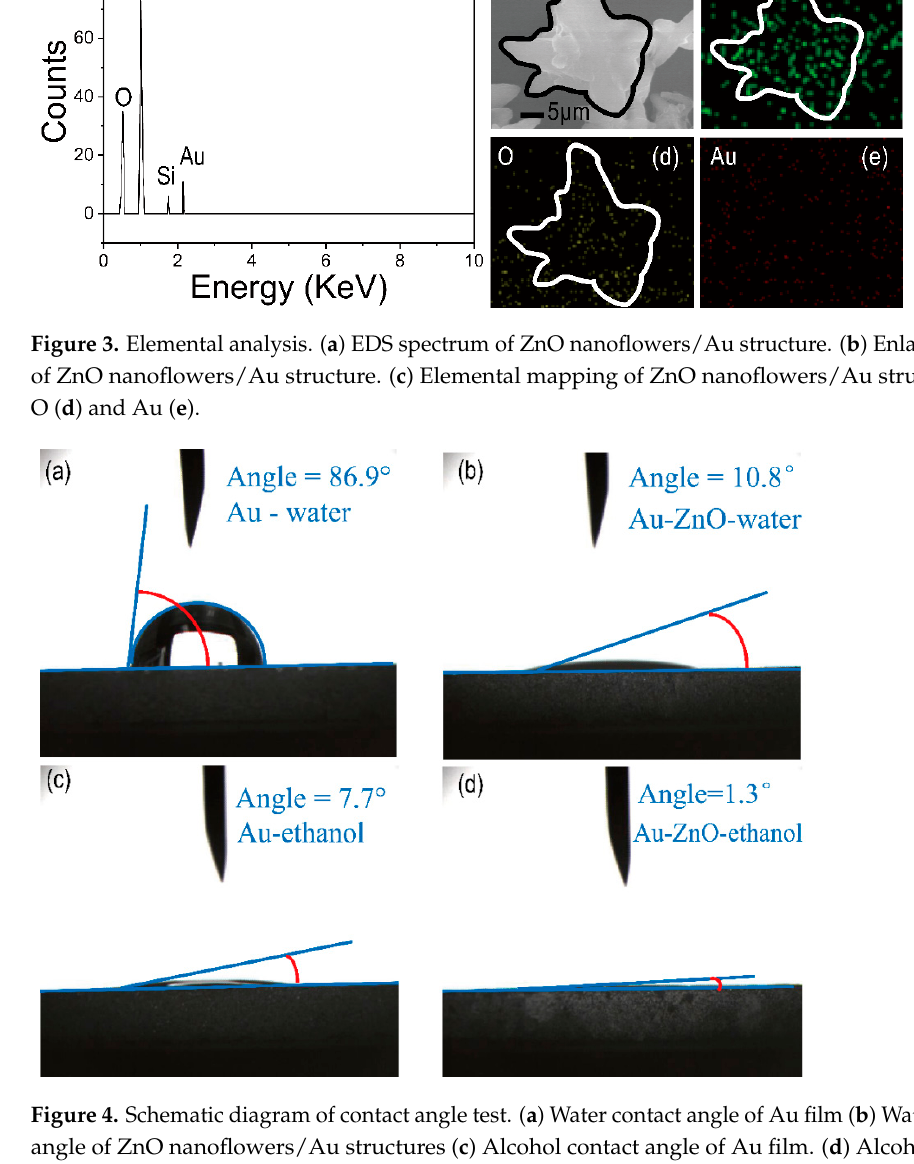
Figure 4. Schematic diagram of contact angle test. ( a ) Water contact angle of Au film ( b ) Water contact angle of ZnO nanoflowers/Au structures ( c ) Alcohol contact angle of Au film. ( d ) Alcohol contact angle of ZnO nanoflowers/Au structures.